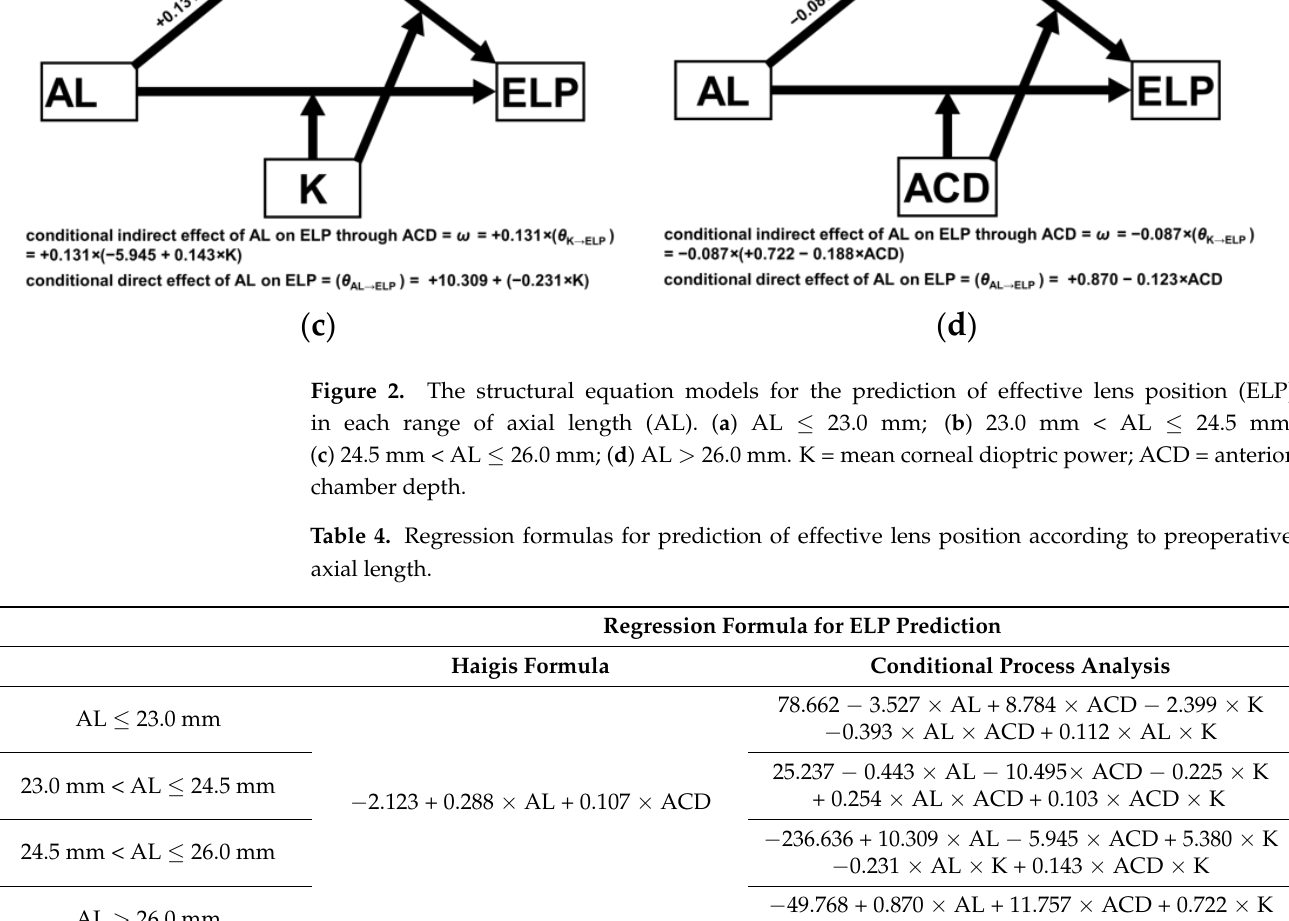
Table 4. Regression formulas for prediction of effective lens position according to preoperative axial length.